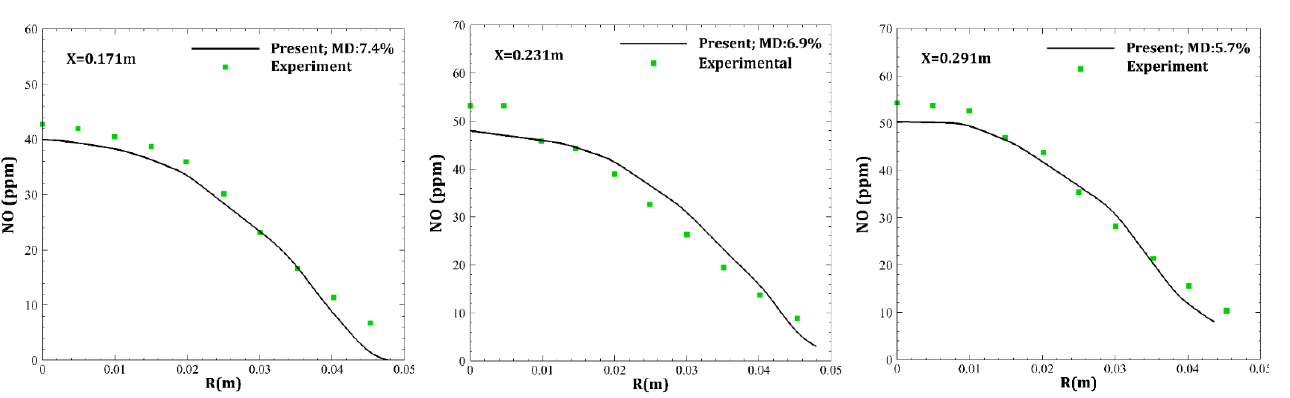
Figure 11. Distributions of ( a ) mean temperature, ( b ) NO concentration and ( c ) total entropy gener- ation rate along mid-plane (Z = 0).